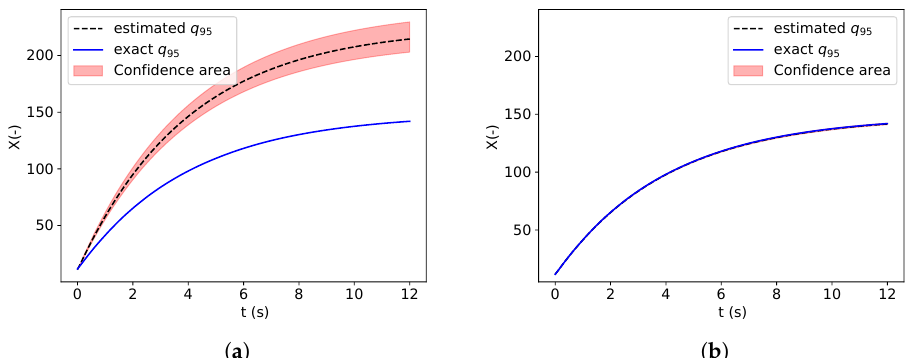
Figure 9. Estimation of the quantile and its confidence area before refinement ( a ) and after 10 active-learning iterations ( b ).